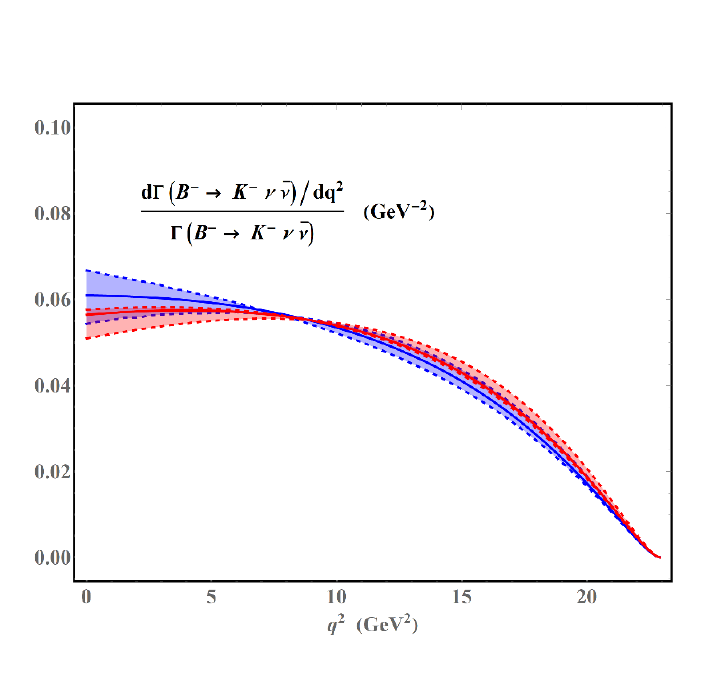
Figure 9 . The normalized di(cid:11)erential q 2 distribution of B ! K(cid:23)(cid:23) computed with the form factors from the B -meson LCSR (pink band) and the Lattice QCD simulations [3] (blue